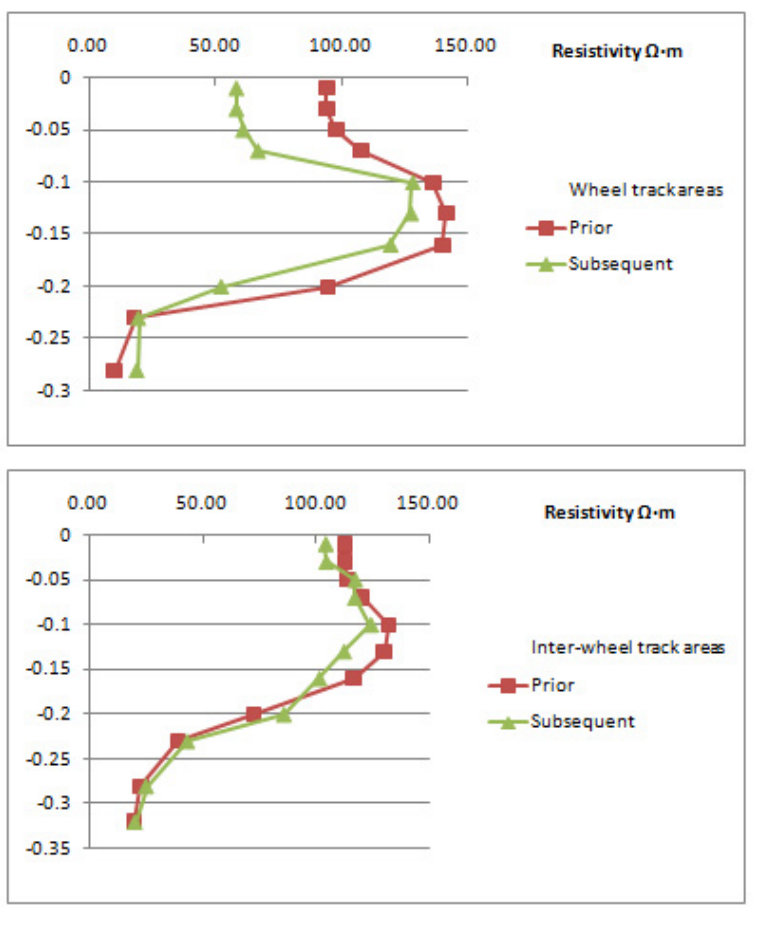
Figure 4: Resistivity (Ω•m) as a function of depth (m) in the wheel and inter wheel track areas, before and after machinery trafficking this study soil water content was 19.5%, and the